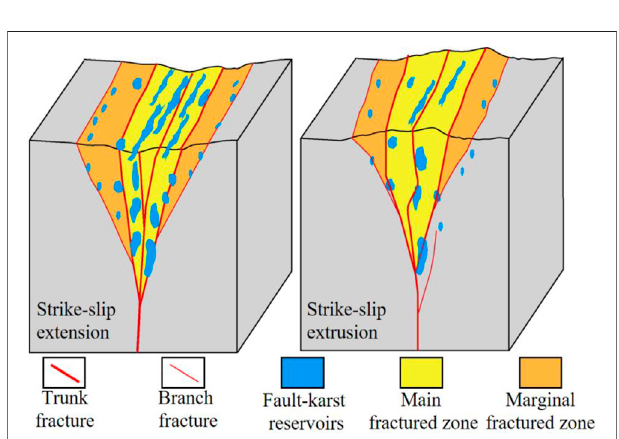
FIGURE 15 | Distribution characteristics of the fault-karst carbonate reservoirs.